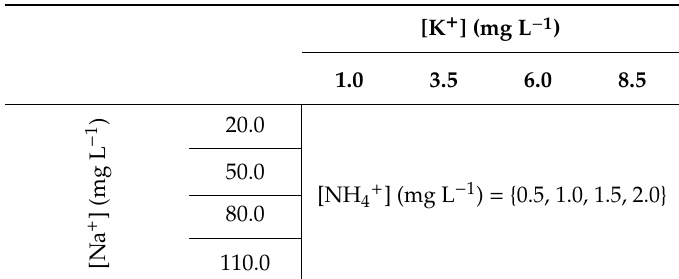
Table 2. Design of the experiment.